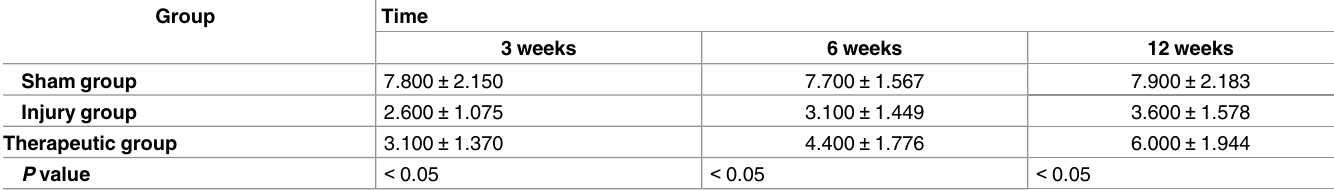
Table 3. Quantitative analysis of type II collagen staining for each group (x ± s, n = 90).